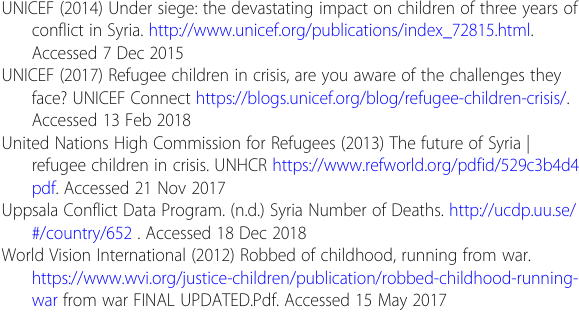
UNICEF (2014) Under siege: the devastating impact on children of three years of conflict in Syria. http://www.unicef.org/publications/index_72815.html. Accessed 7 Dec 2015 UNICEF (2017) Refugee children in crisis, are you aware of the challenges